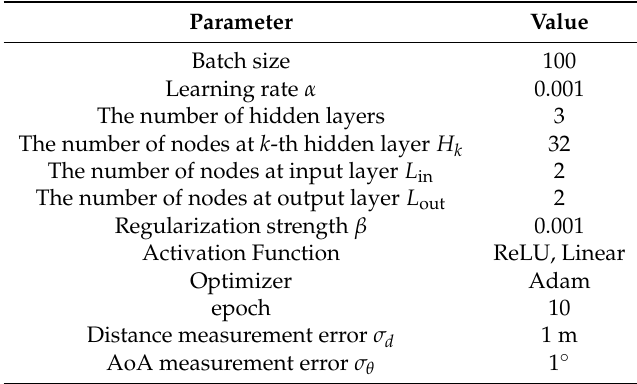
Table 1. Hyperparameters of deep neural network